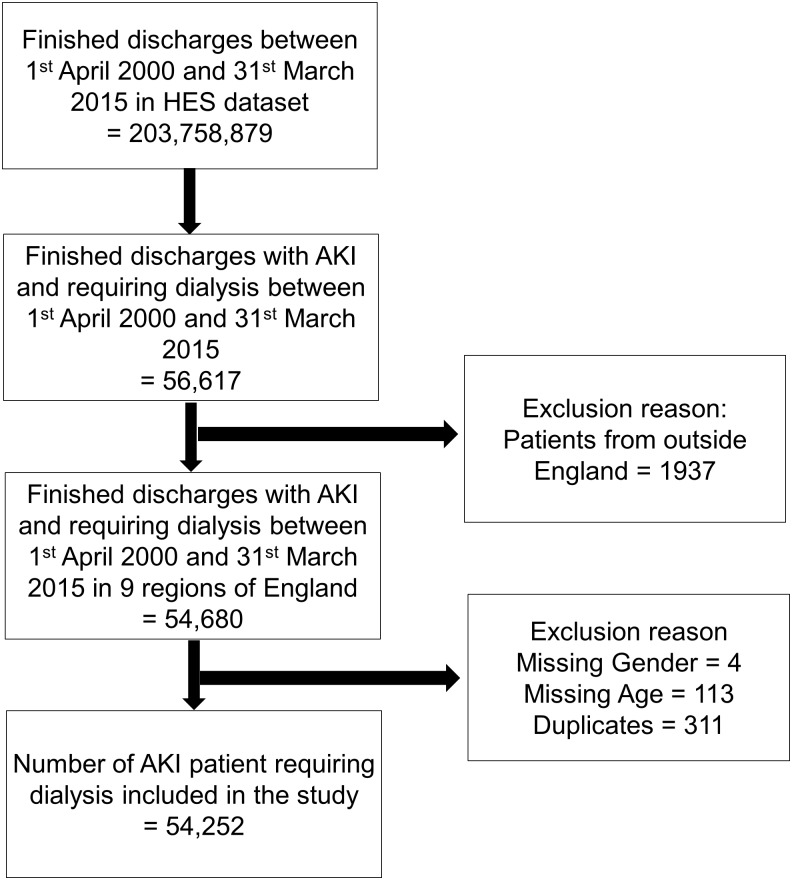
Study flowchart.